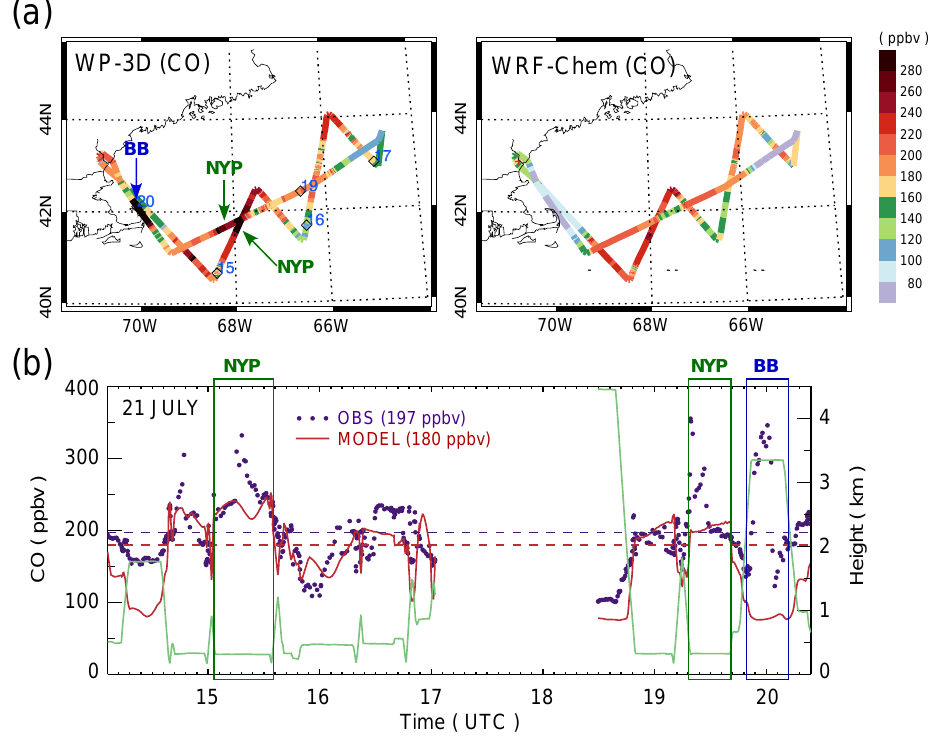
Fig. 5. (a) Observed and simulated CO mixing ratios along the WP-3D flight track on 21 July. Times of aircraft measurement are depicted. (b) Comparison of observed (dot) and simulated (red line) CO mixing ratios on 21 July as a function of time. “NYP” and “BB” indicate New York City urban plumes and biomass-burning plumes. Green solid line denotes the aircraft altitude. Dashed lines and values in (b) indicate mean mixing ratios below 1.5km in observation and simulation, respectively. The WP-3D was located outside of the model domain for the missing period from 17:00 to 18:30